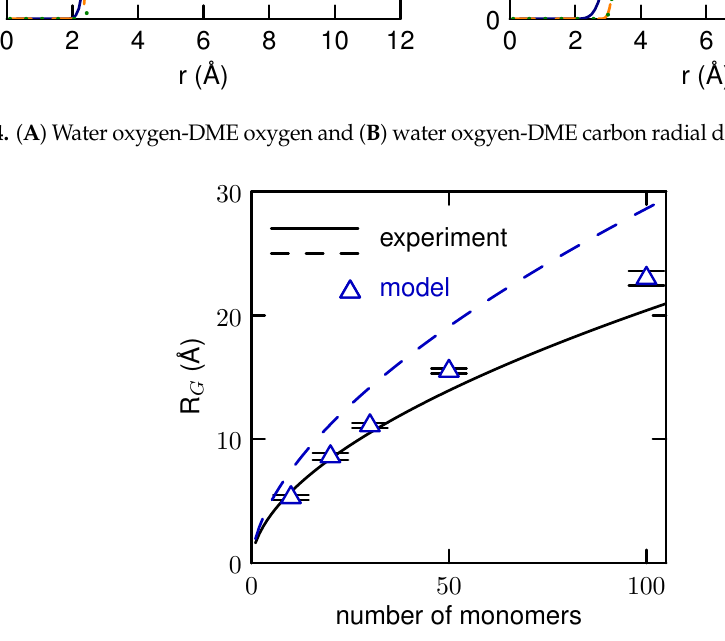
Figure 5. Radius of gyration of PEO as a function of